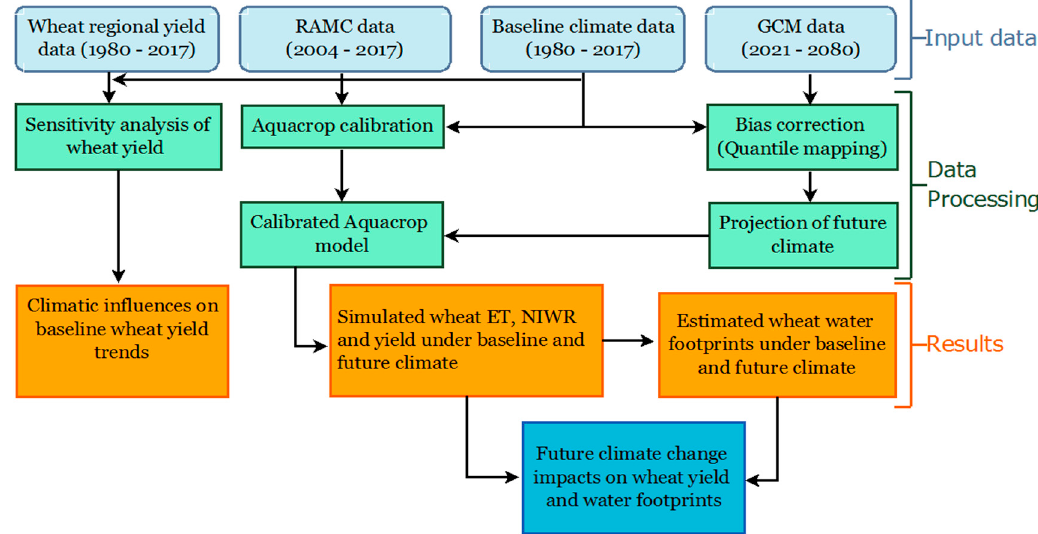
Figure 2. Methodological framework followed in this study for estimating the future wheat yield variability and water footprints.